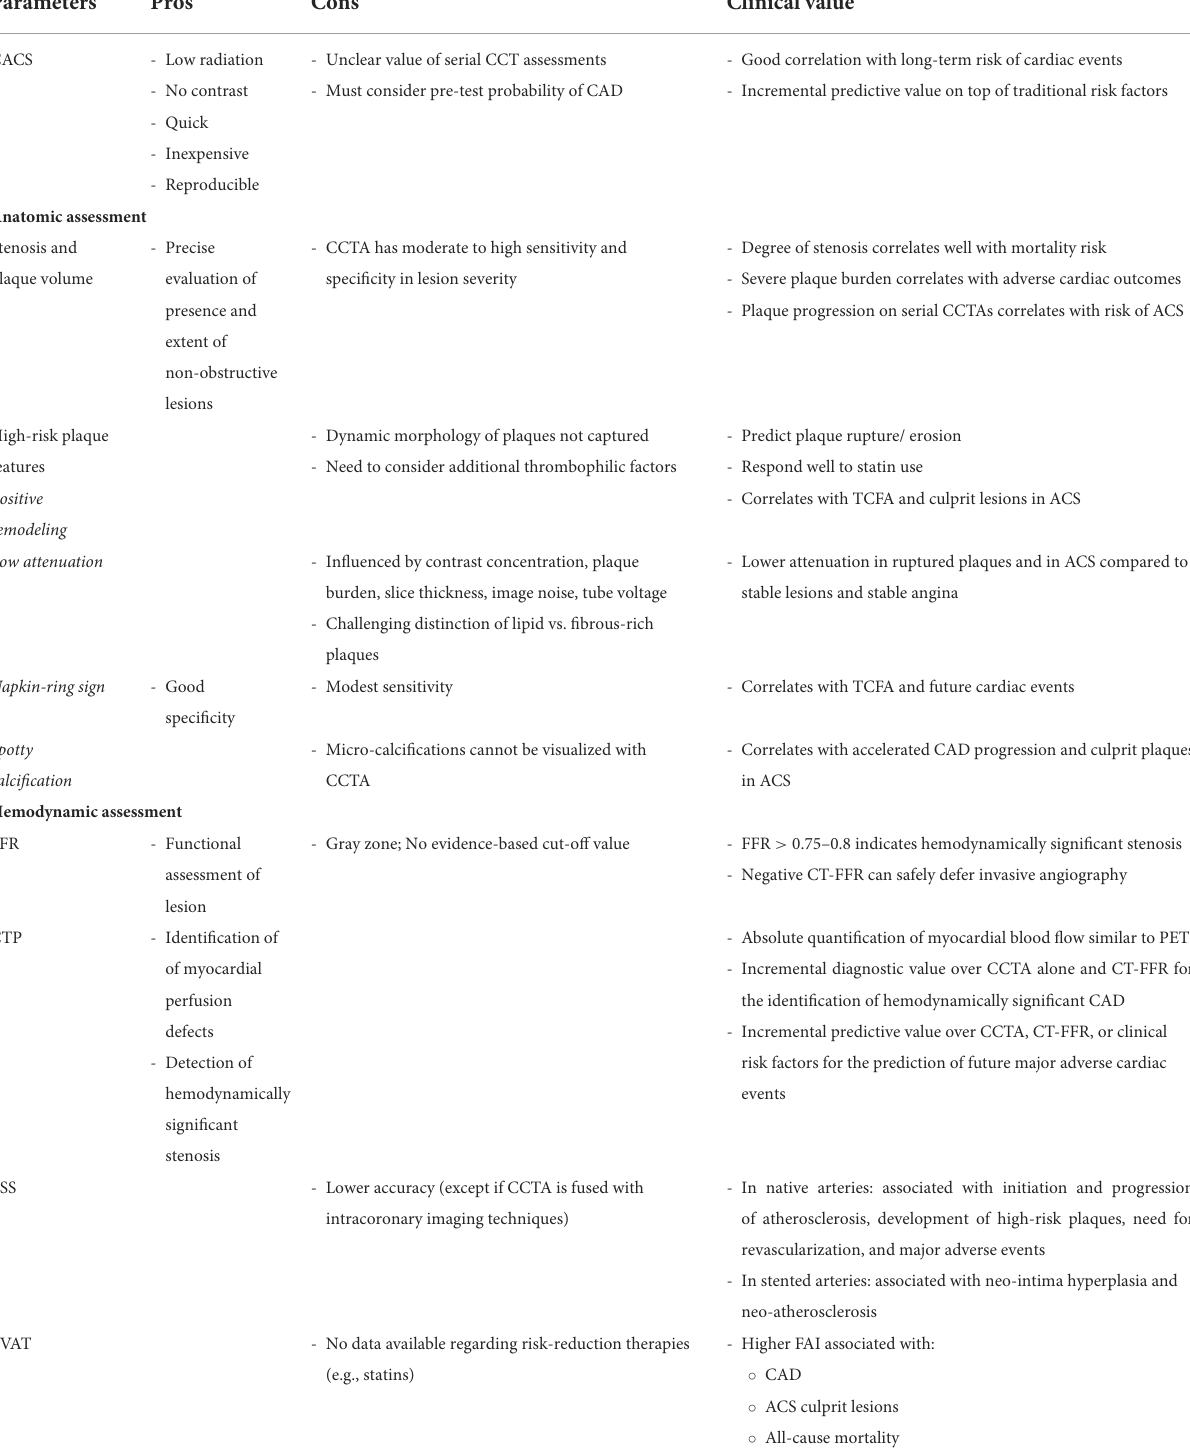
TABLE 1 Cardiac computed tomography derived parameters: pros, cons, and clinical value. Parameters Pros Cons Clinical